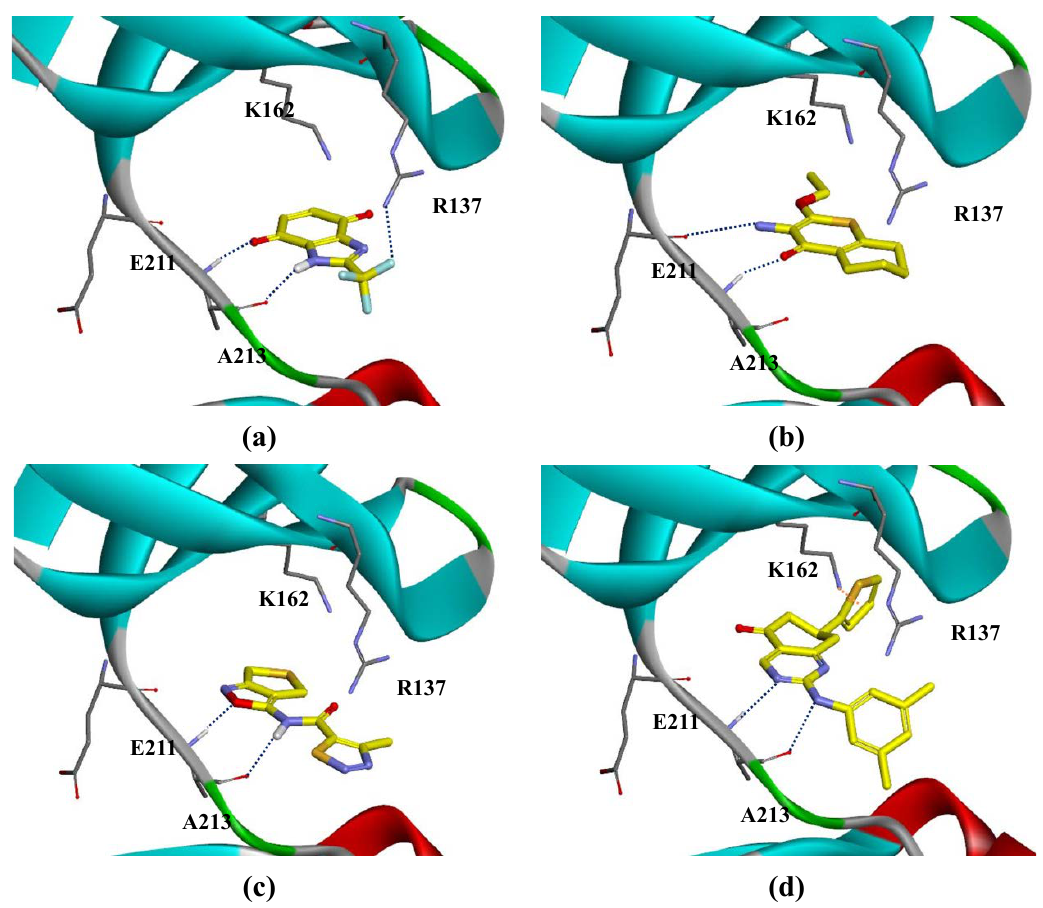
Figure 1. The binding mode of fragments: ( a ) 12; ( b ) 1; ( c ) 13; and ( d ) 3, (PDB code: 3P9J). Hydrogen bond is shown in blue dotted line and π-interaction is shown in orange dotted